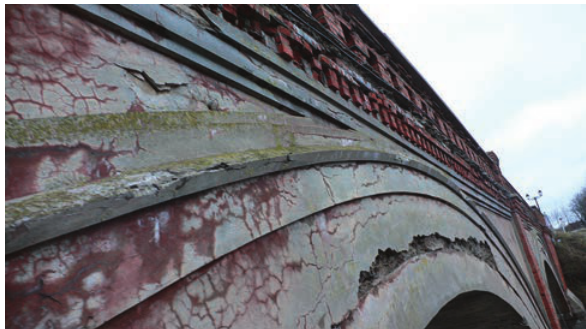
Fig. 6. Cracks and spalling in the reinforced concrete span surface